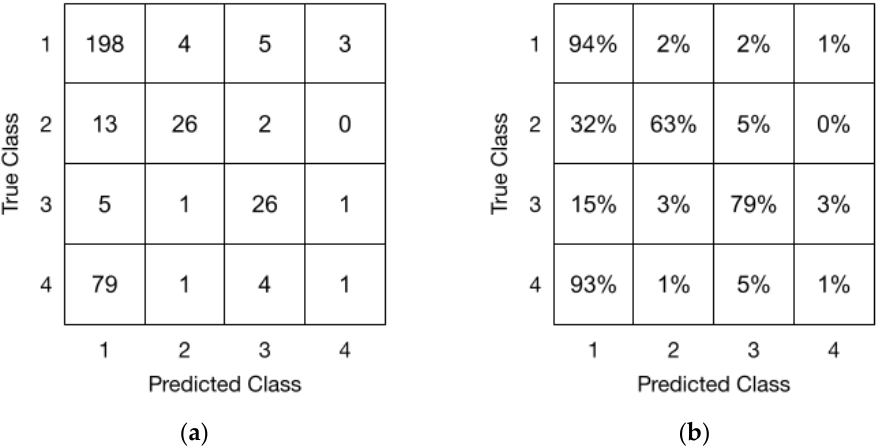
Figure 6. Confusion matrix of the classification algorithm with the best accuracy (linear SVM) after the feature selection process. Class 1, cable insulation failure; Class 2, excavation damage; Class 3, secondary substation busbar; Class 4, cable joints failure. ( a ) Numerical values; ( b ) percentages considering the elements in each true